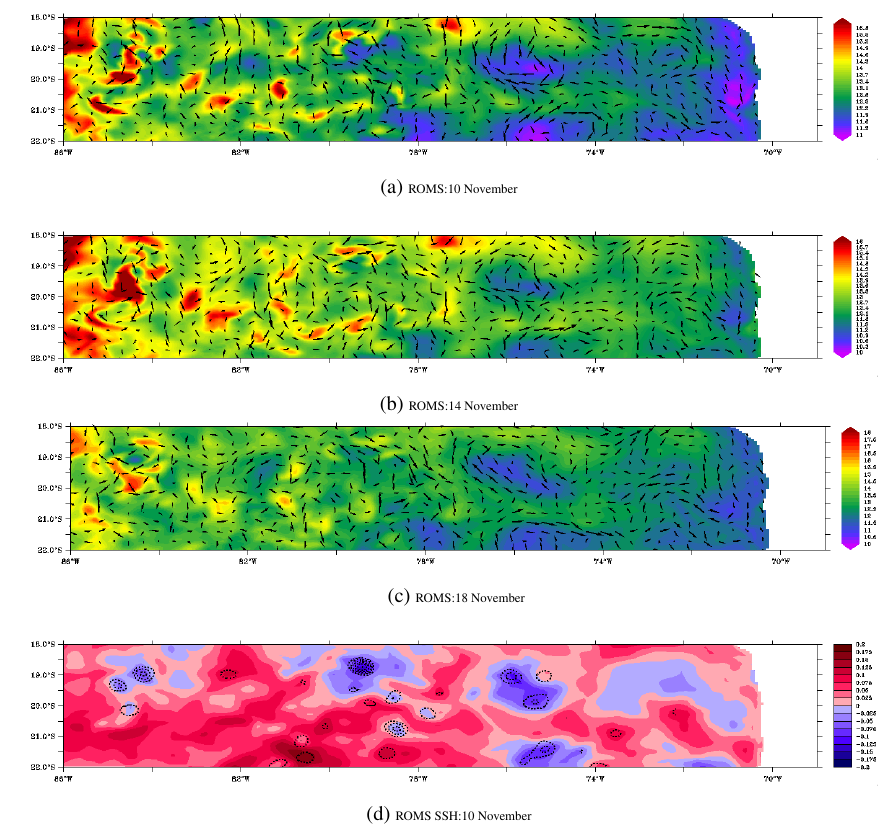
Fig. 11. Temperature (in ◦ C) at 250m Depth in the ocean state estimate for three different days (a) 10 November, (b) 14 November and Fig. 11: Temperature (in ◦ C) at 250 m Depth in the ocean state estimate for three different days (a) (c) 20 November showing the evolution of the eddy in time in the model. The last (d) is the color contours of SLA with the Okubo-Weiss 10 November, (b) 14 November and (c) 20 November showing the evolution of the eddy in time in parameter overlaid on top to show eddy like the model. The last (d) is the color contours of SLA with the Okubo-Weiss parameter overlaid on top to show eddy like structures.